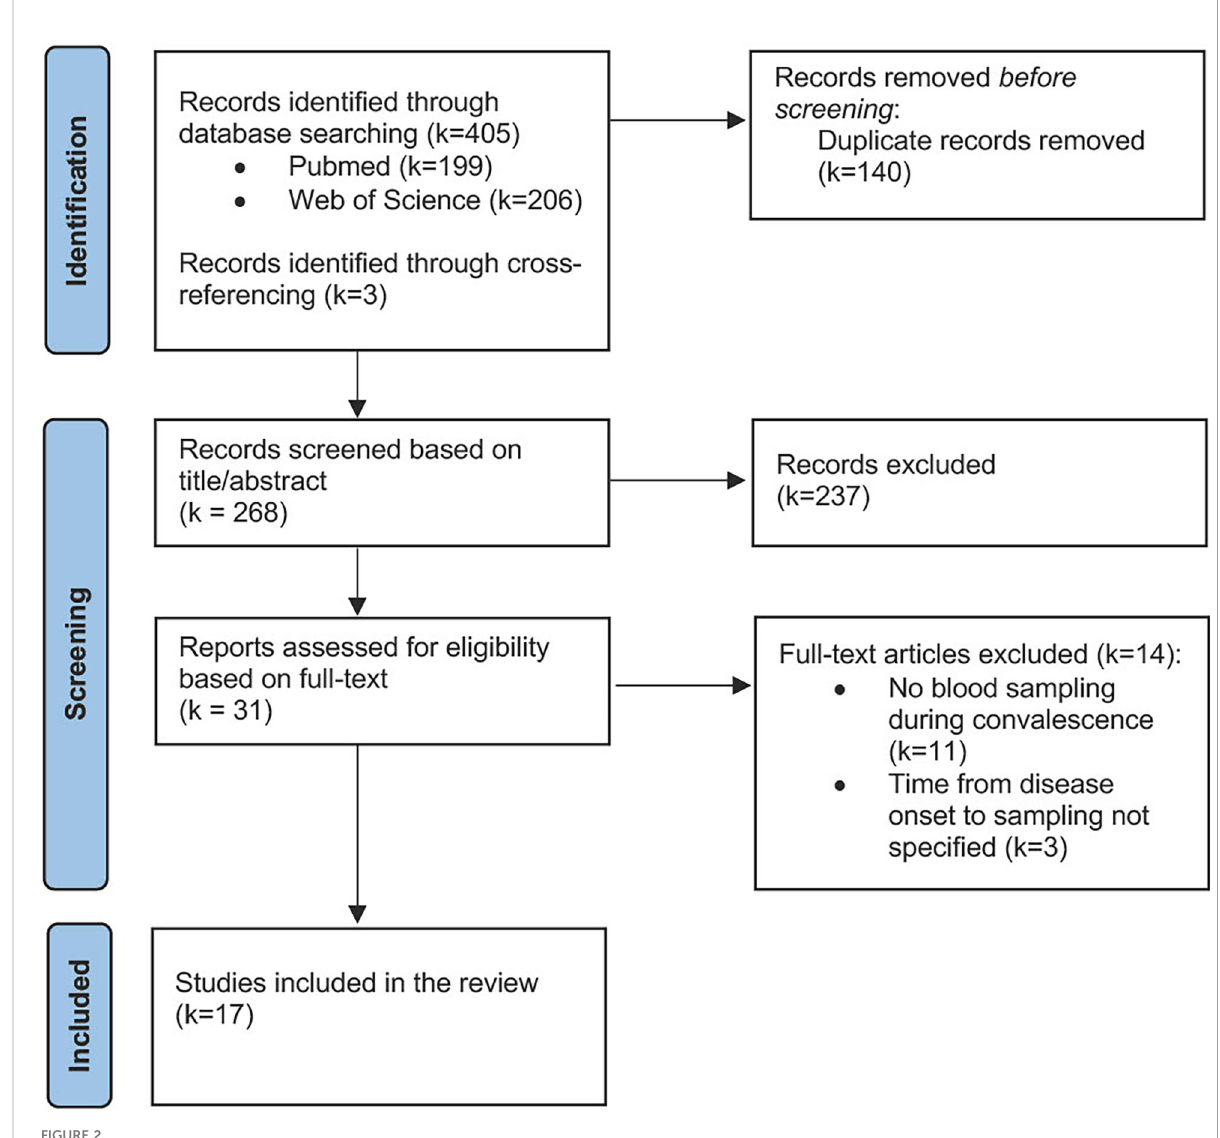
FIGURE 2 Flow diagram illustrating the literature search and study